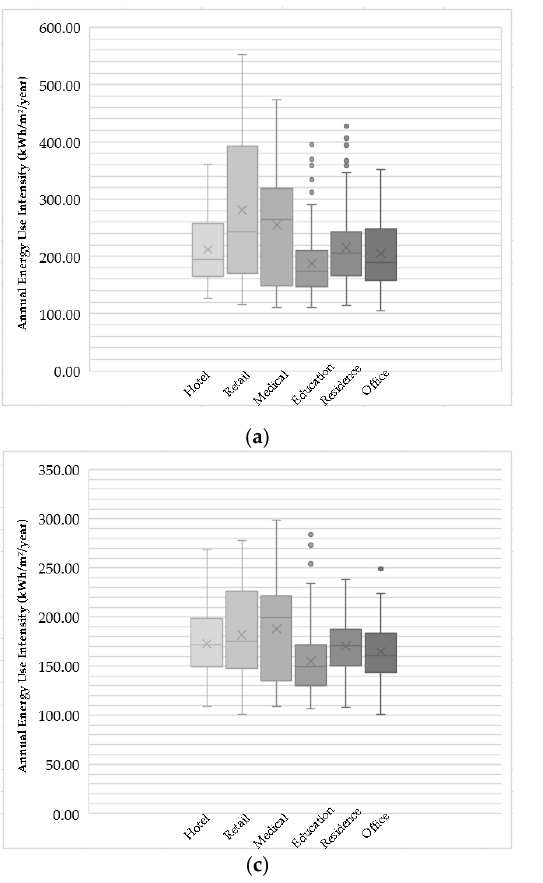
Figure 9. Boxplot of EUI of sample buildings. ( a ) Total EUI; ( b ) electricity EUI; ( c ) heating EUI.